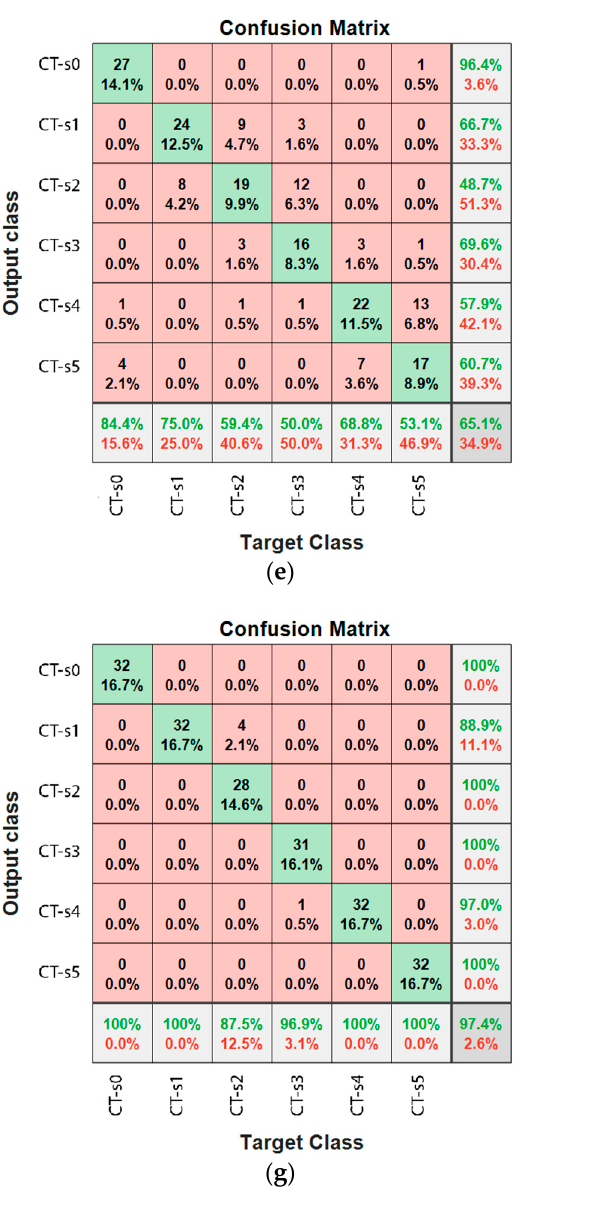
Figure 12. Confusion matrices and classification results obtained for the 100 m/rev tests: ( a ) confusion matrix for image analysis; ( b ) classification of tool wear for image analysis; ( c ) confusion matrix for stray flux analysis; ( d ) classification of tool wear for stray flux analysis; ( e ) confusion matrix for current analysis; ( f ) classification of tool wear for current analysis; ( g ) confusion matrix for image, current and stray flux fusion; ( h ) classification of tool wear for image, current and stray flux fusion.